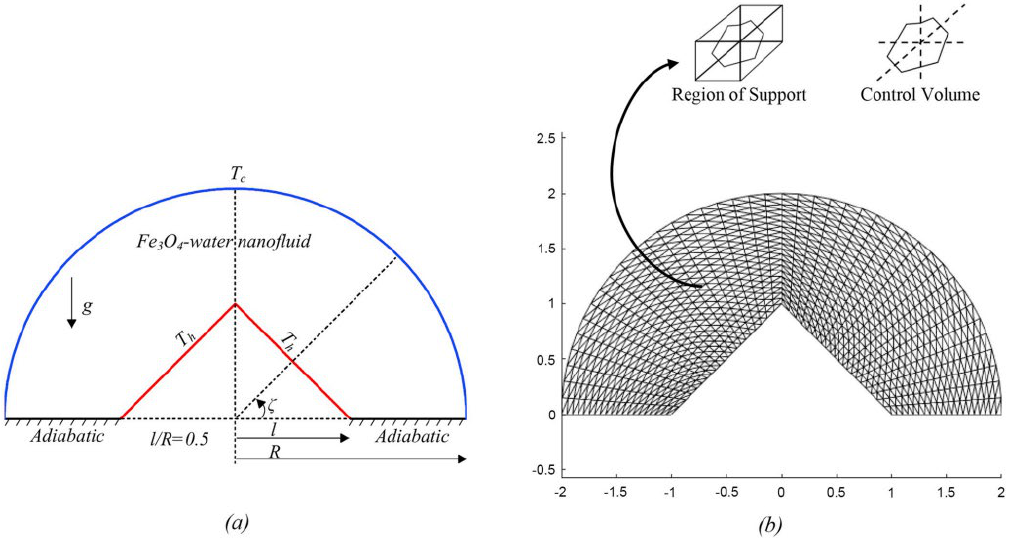
Figure 3. ( a ) Physical model and coordinate system and ( b ) grid distribution. Reprinted with permission from Ref. [18]. 2020, Elsevier.